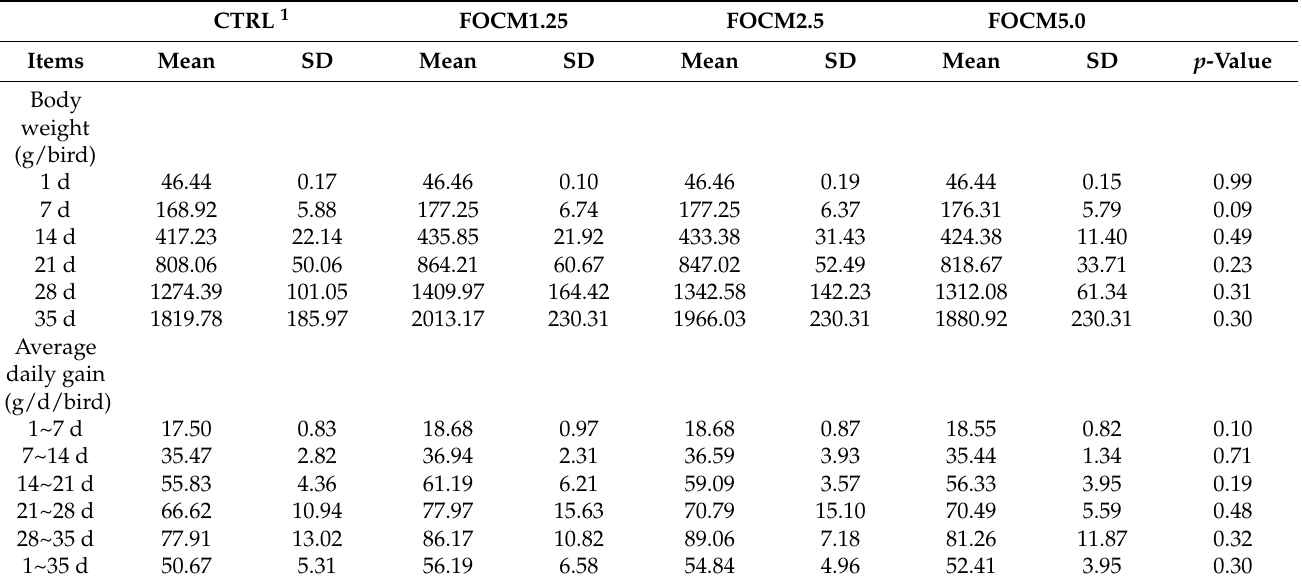
Table 2. Effect of FOCM supplemented in diet on body weight and average daily gain in broilers.